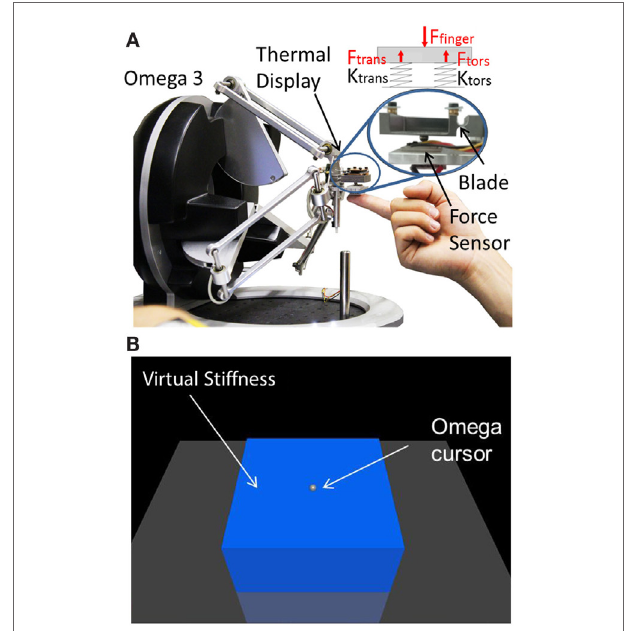
FigUre 6 | Photo of the experimental setup . Experimental setup. (a) The thermal display is mounted on the Omega 3 force feedback device to provide a multimodal stimulation. For stiffness palpation the subject placed the finger on the thermal display. Between trials, the subject placed the finger under the end effector on a PE kept at the finger base temperature (as illustrated here). (B) A virtual environment was used to instruct the participants during the two-alternative forced-choice